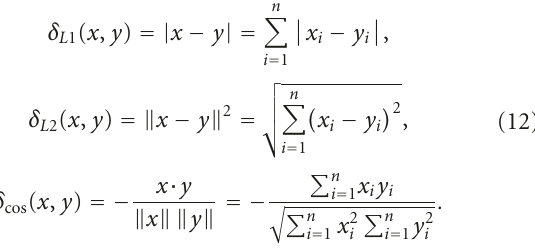
Figure 8: Impulse response of single-tree complex wavelet at 4 levels and 6 directions. (a) Real part. (b)